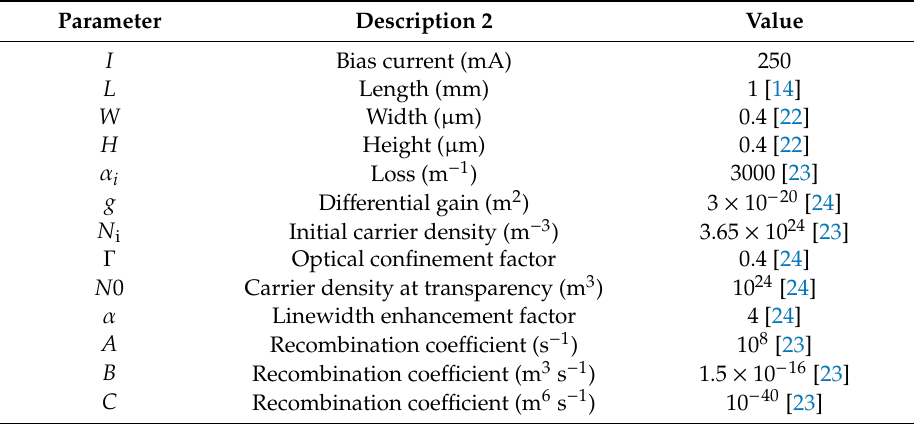
Table 1. Geometrical and material parameters used in the simulation.